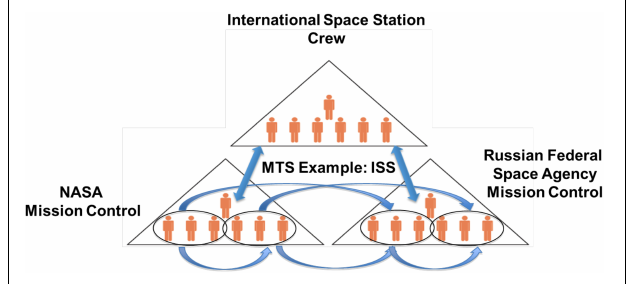
FIGURE 1 | Multiteam systems in spaceflight: international space station